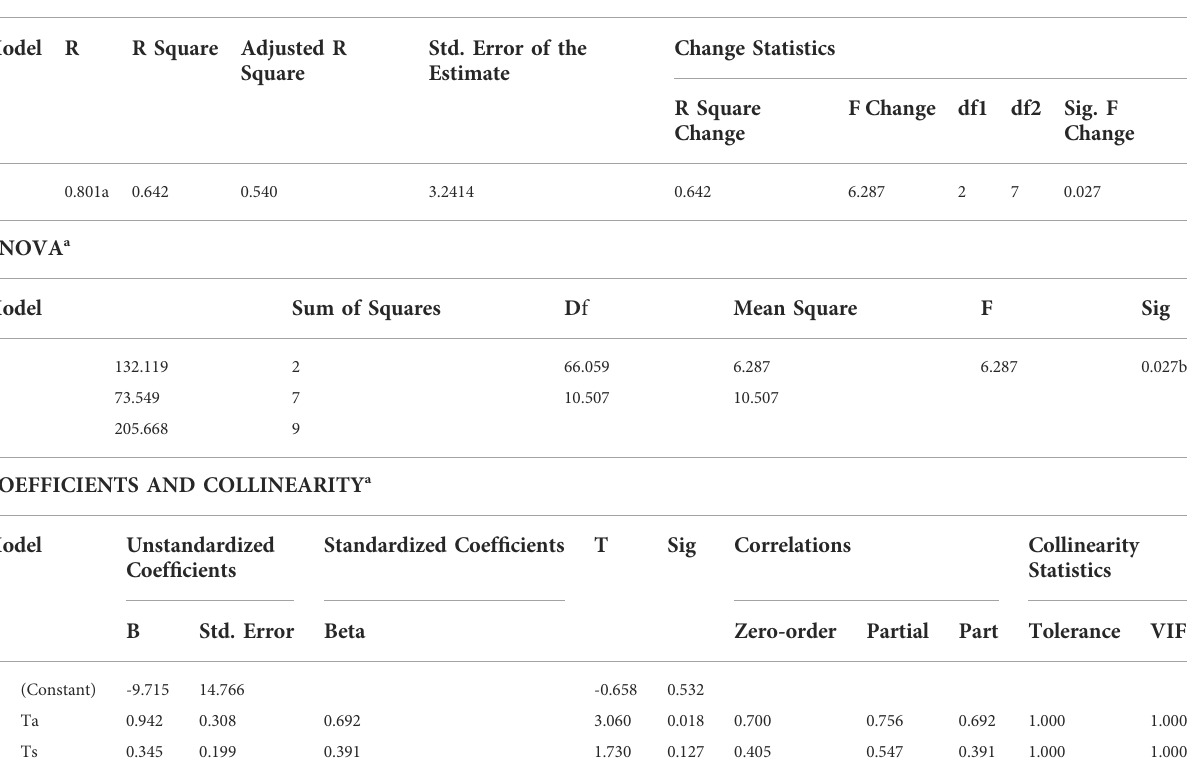
TABLE 5 Model summary, ANOVA, and coef fi cients of cabin